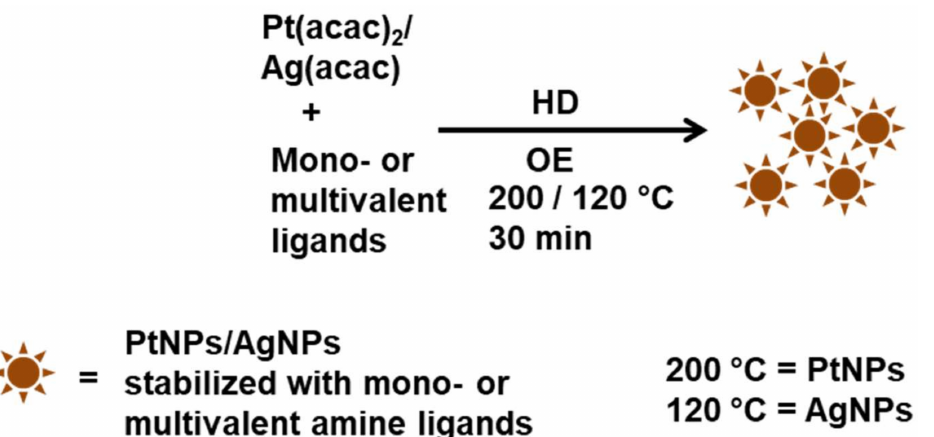
Scheme 2. Schematic representation of the synthesis of AgNPs and PtNPs with mono- and